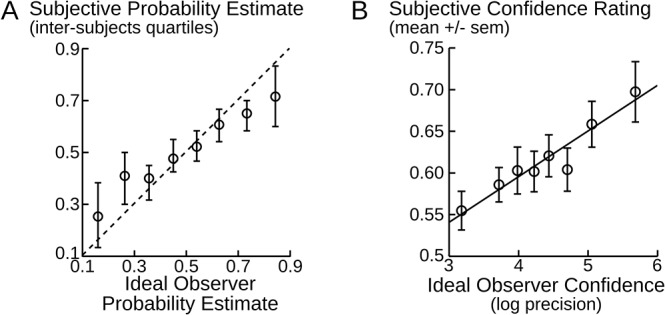
Accuracy of probability estimates and confidence.
(A) Estimated probability that the next stimulus is A plotted against the Ideal Observer estimate. These probability estimates correspond to the transition probabilities p(A|A) or p(A|B), depending on whether the previous stimulus was A or B; both are pooled together. The dotted line corresponds to the identity. Error-bars and dots are the 75%, 50% and 25% percentiles across subjects. (B) Subjective confidence plotted against the Ideal Observer confidence. The steps of the subjective confidence scale were coded such that 0 corresponds to 'Not at all sure' and 1 to 'completely sure'. The Ideal Observer confidence is summarized as the log precision,-log(σ2), with σ² the variance of the estimated transition probability distribution. The fitted line is the average of the linear fits performed at the subject level. In A & B, equally-filled data bins were formed along the horizontal axis because the sequence of stimuli (and hence, estimates that can be inferred) differed across participants. Bins are used only for visualization and not for data analysis.